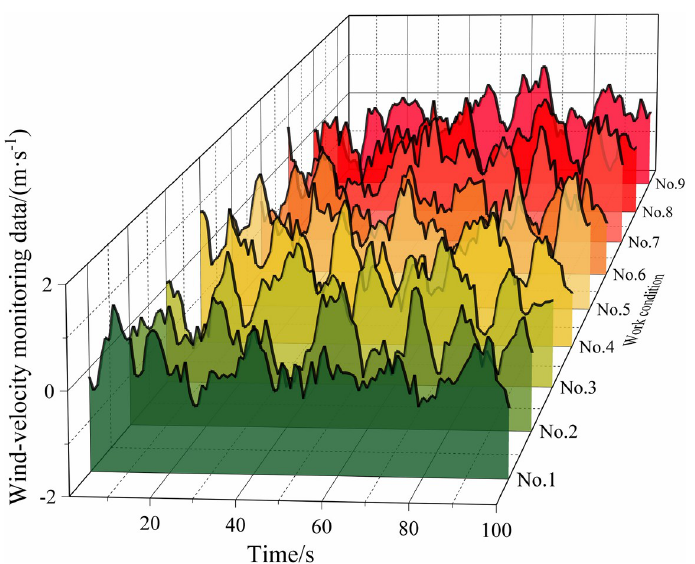
Fig 13. Wind-velocity data recorded at monitoring Point 4.